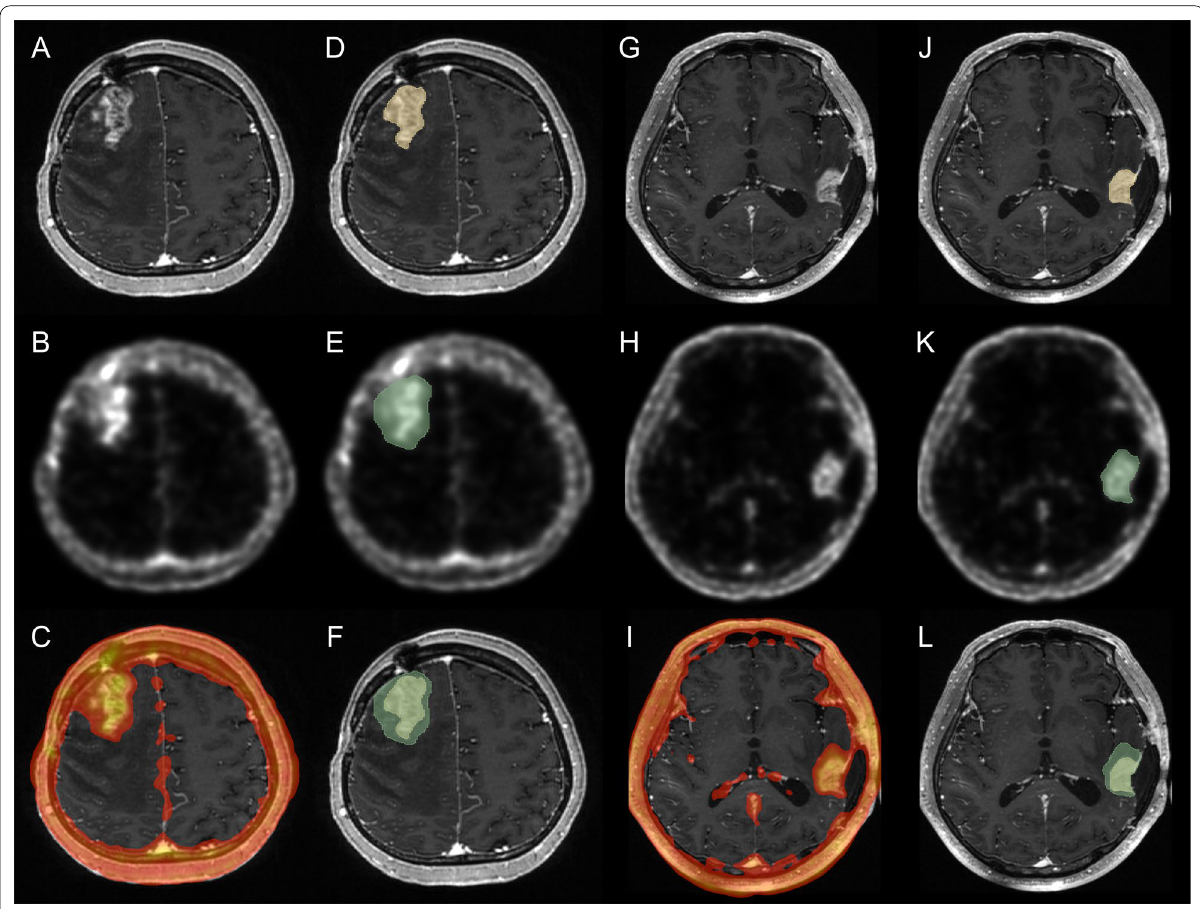
Fig. 1 Examples of MRI and FBY PET images in diffuse tumors. A right frontal recurrent WHO grade III oligodendroglioma (IDH mutant, chromosomal 1p/19q codeletion) displayed significant contrast enhancement ( A ) and FBY activity ( B ), with increased FBY uptake seen beyond contrast enhancement in the lateral and posterior regions ( C ). Semiautomated segmentation based on MRI ( D ) and FBY PET ( E ) was performed, and nonconcentric expansion of the FBY-based segment compared with the MRI-based segment was noted ( F ). Similarly, a left temporal recurrent WHO grade IV glioblastoma (IDH-wild type) exhibited contrast enhancement ( G ) and FBY radioactivity ( H ), with the increased FBY uptake extended anteriorly and medially ( I ). The semiautomated segmentations ( J , K ) also verified the extension of the ROI FBY to the potential invaded regions (with an abnormal T2-weighted signal). This characteristic may result from the infiltrative nature of diffuse gliomas and indicates that FBY can be absorbed in both contrast-enhanced regions and infiltrative noncontrast-enhanced